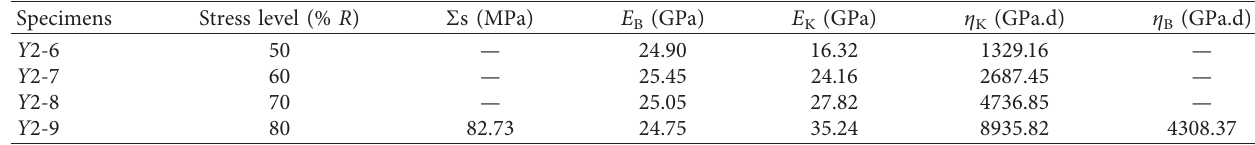
Table 6: Recommended creep parameters of iron ore.